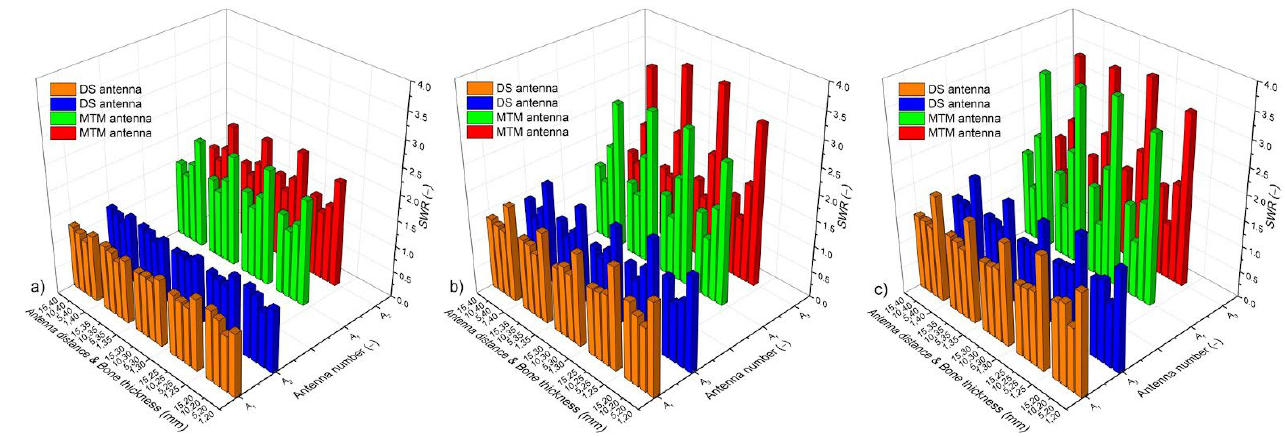
Figure 4. SWR of the antennas that compose the analyzed antenna arrays. ( a ) linear antenna array, ( b ) triangular antenna array (SWR for A 2 is within the values of A 1 and A 3 ), and ( c ) square antenna array (SWR for A 2 and A 4 is within the values of A 1 and A 3 ). DS = double slot antenna, MTM = monopole antenna; A 1 , A 2 , A 3 , and A 4 correspond to the antenna number in each antenna array.